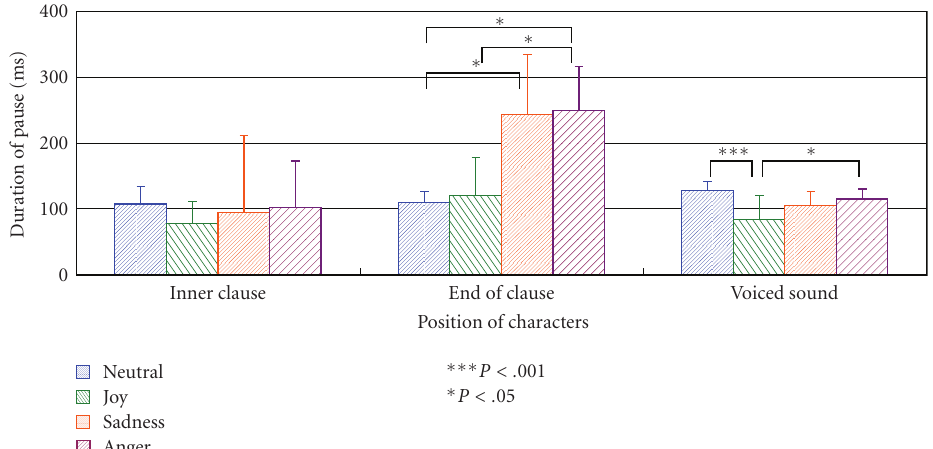
Figure 14: Mean of duration of pause as a function of emotions and position of characters for two-handed Finger Braille (error bars represent standard deviations).